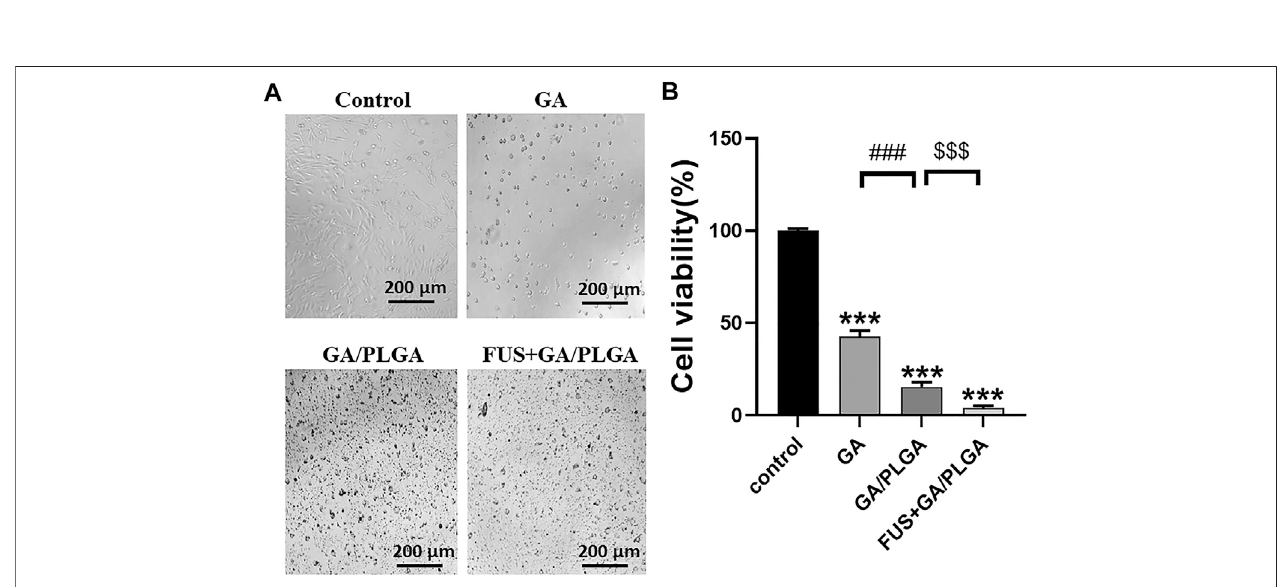
FIGURE4|(A) Afterfourdifferenttreatmentsfor24 h,thesurvivalstateofU251cellsineachgroupwasobservedunderamicroscope. (B) ThecellviabilityofU251 cells in each group was detected by the CCK-8 reagent. The cell viability of the FUS + GA/PLGA group was 3.85 ± 0.67% (*** p < 0.001 versus the control group and $$$ p < 0.001 versus the GA/PLGA